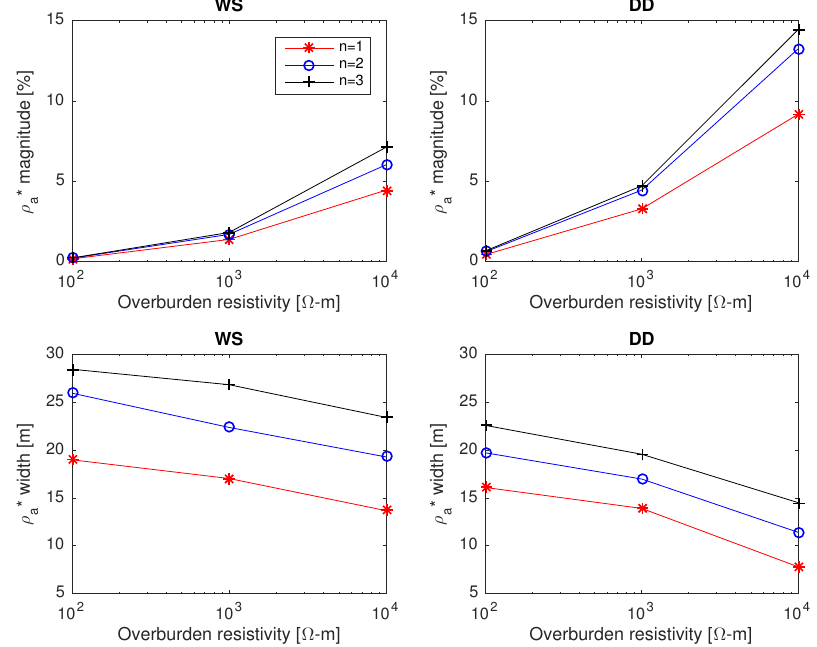
Figure 6. Apparent resistivity anomaly magnitude and width as a function of overburden resistivity for the case of a single, 1-mm-aperture fracture having length (cid:96) = 5 m, electrical resistivity ρ f = 10 Ω · m, and dipping at 45 ◦ . The fracture is hosted in bedrock having resistivity ρ b = 10,000 Ω · m. The overburden thickness is 1 m. The measurement configuration is denoted by WS (Wenner-Schlumberger) or DD (dipole-dipole) with spacing factor n . Cases 2, 10, and 11 from Table 1 are